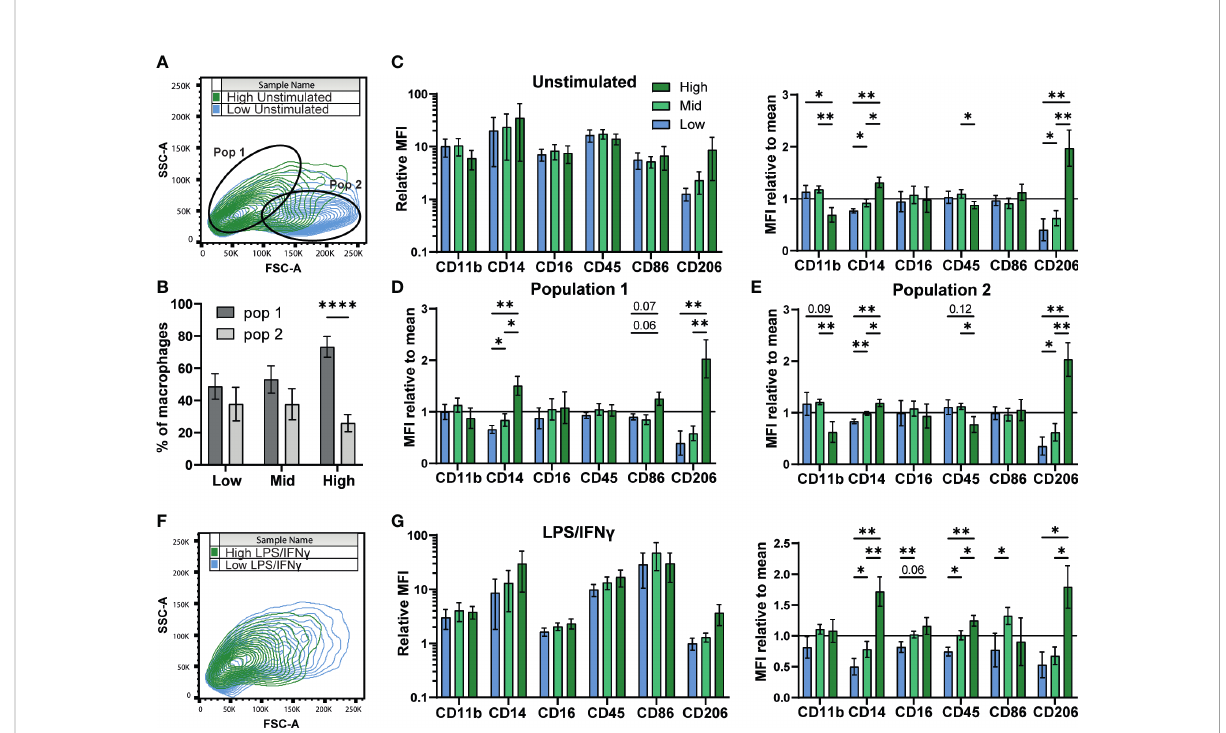
FIGURE 3 Density in fl uences surface marker phenotype dependent and independent on morphology. (A, B) iPSC-Macs separate out into two populations measurable by comparing shape and granularity by fl ow cytometry. (B) n=5, 1 iPSC line, Two-way ANOVA, Sidak ’ s multiple comparisons test. (C-E) Expression of macrophage markers by different density resting iPSC-Macs. (C) Left; Mean fl uorescence intensity (MFI) calculated by normalization of fl uorescence against an isotype control. Right; MFI normalized by dividing by the mean of all 3 densities. (D) MFI normalized to the group mean subgating for population 1 and (E) population 2. (F) Differences in size and granularity are lost after polarization. (G) Left; MFI, and right; MFI normalized to the group mean, of macrophage markers on polarized iPSC-Macs. (C-G) n=5 (CD86 n=4), 1 iPSC line, mixed effects analysis, Tukey ’ s multiple comparisons test with Greenhouse-Geisser correction. Signi fi cance is de fi ned as * <0.05, ** <0.01,